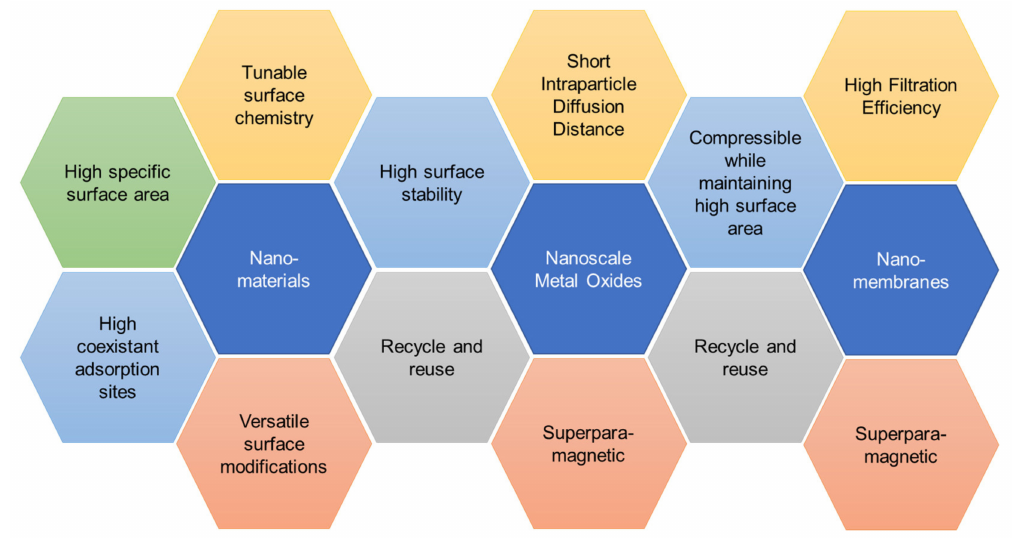
Figure 2. Nanomaterials and their surface properties that can be control in various